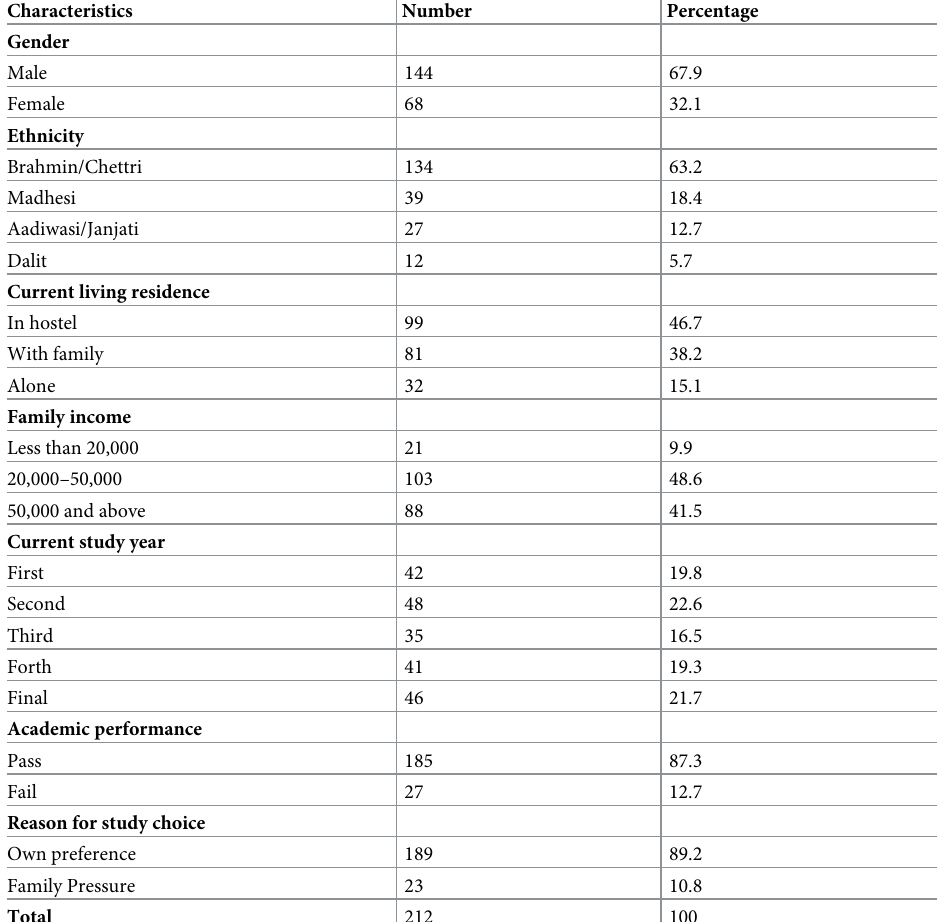
Table 1. Socio-demographic characteristics of study participants.